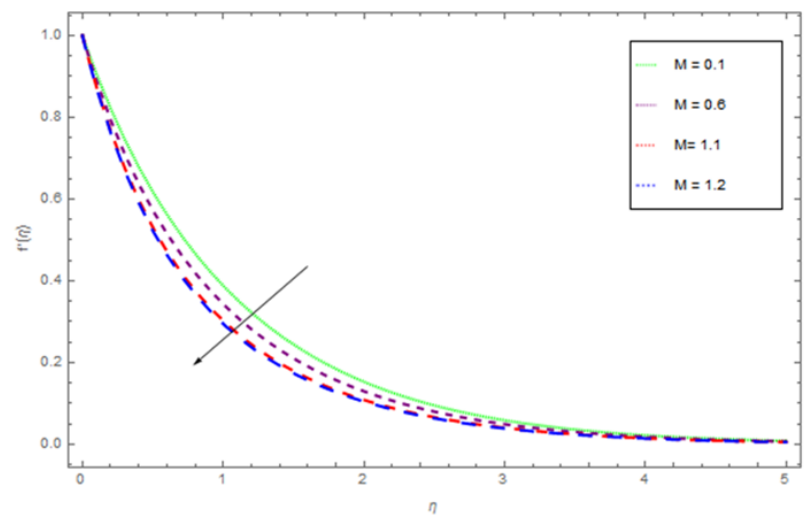
Figure 2. The influence of M on f (cid:48) ( η ) when k 1 = 0.2, F = 0.1, λ = 0.3, γ = 0.4.